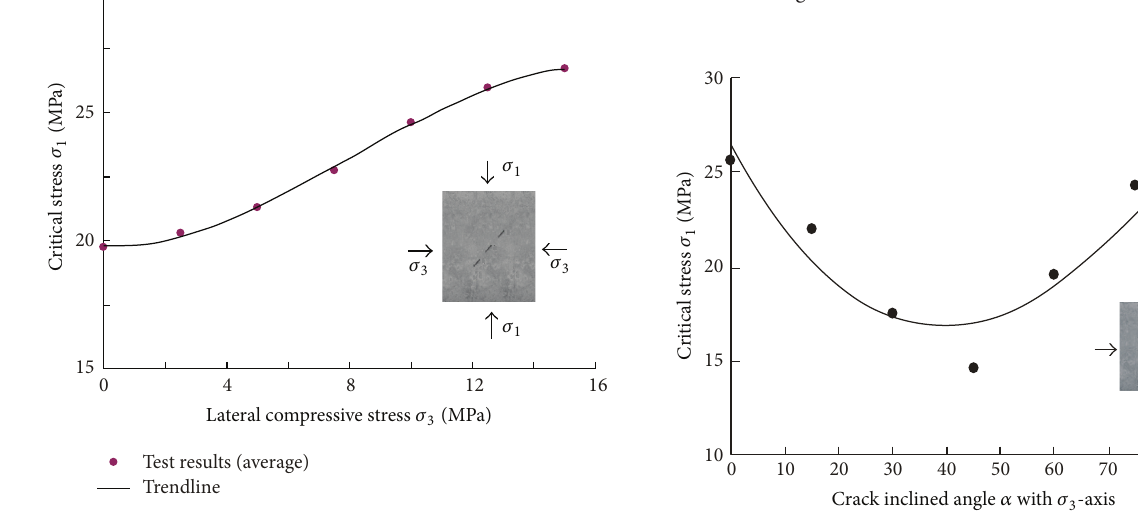
Figure 5: Crack fracture patterns for the specimens with different inclination angles.